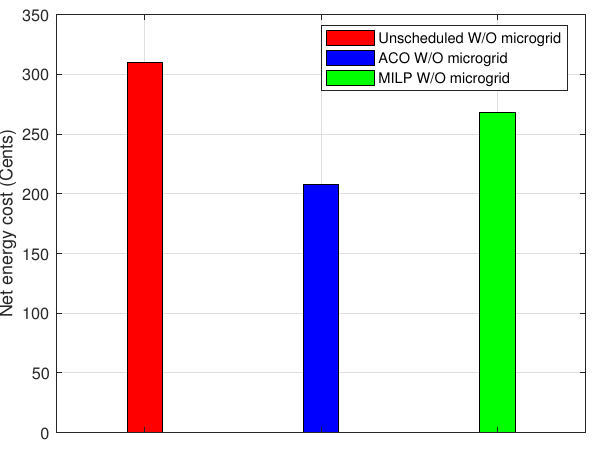
Figure 8. Energy cost per day